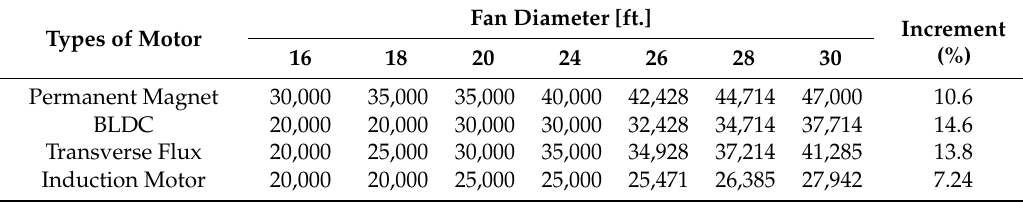
Table 6. Increment percentage of Monstrous fan forecasting according to motor